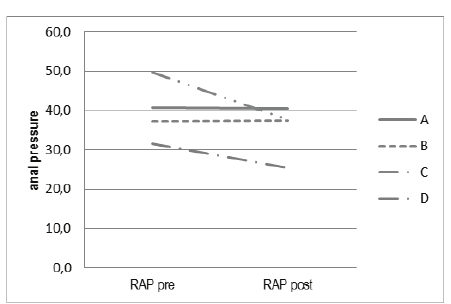
Figure 1: Mean resting anal pressure in mm Hg before (RAP preMSP), during (MSP), after maximum squeeze maneuver (RAP postMSP), and voluntary contraction pressure measured during squeeze maneuver.